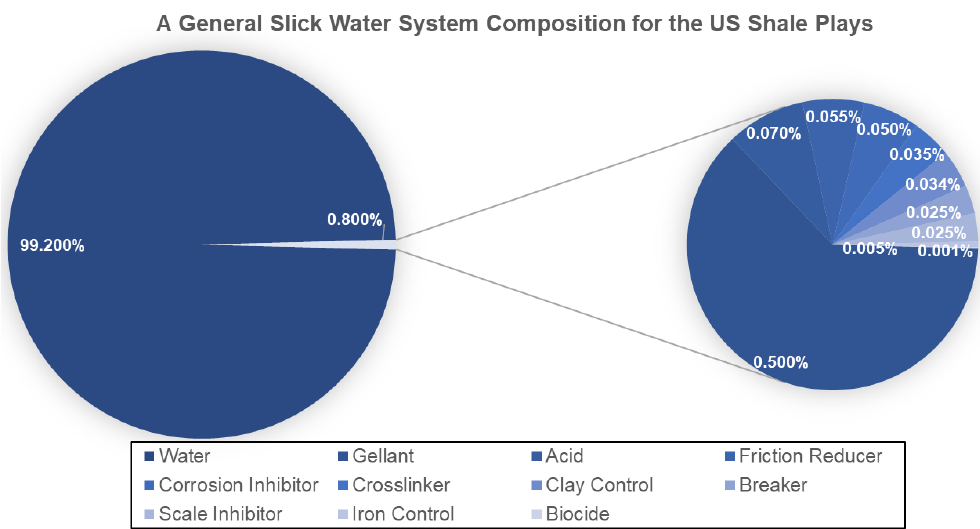
Figure 3—Volumetric composition of a general slickwater system for the US shale plays (edited with source data from